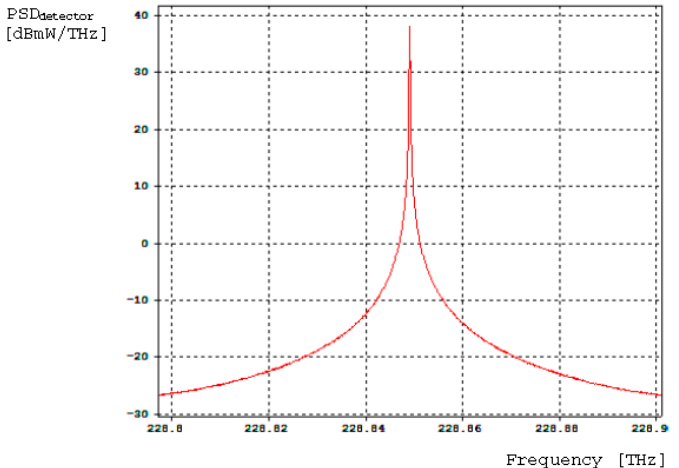
Figure 11. Power-Spectral-Density (PSD) curve obtained at the photodetector optical-input (probe 2 in Figure 9).